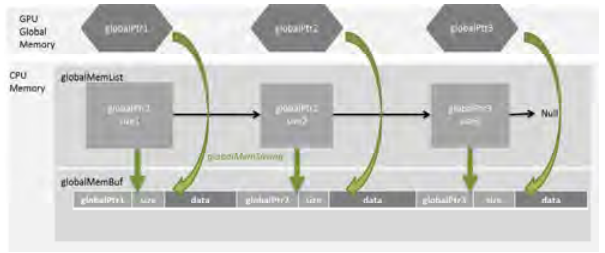
Fig. 9. Process Layout of Global Memory Saving Function globalMemSaving(bufferType*